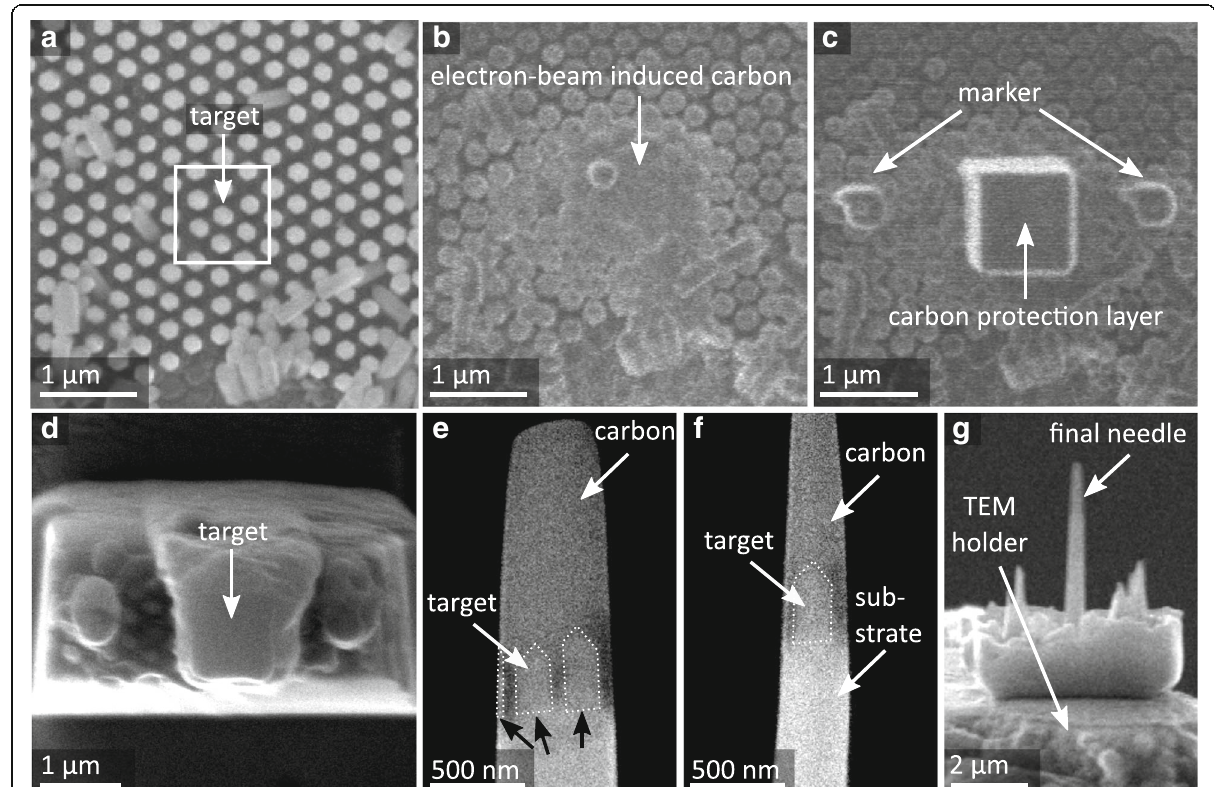
Fig. 2 SEM micrographs showing a an array of NW and the selected area for the FIB needle preparation (white box), b the NW embedded in electron beam-induced carbon, c the gallium beam-induced carbon as thick deposition layer on top of the selected area and two additional markers, d the isolated needle ready for lift-out, e , f the thinned tomography needle (black arrows indicate NW positions), and g an overview of the final tomography